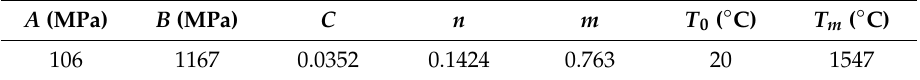
Table 2. The Johnson–Cook model constants for AISI-4140 steel